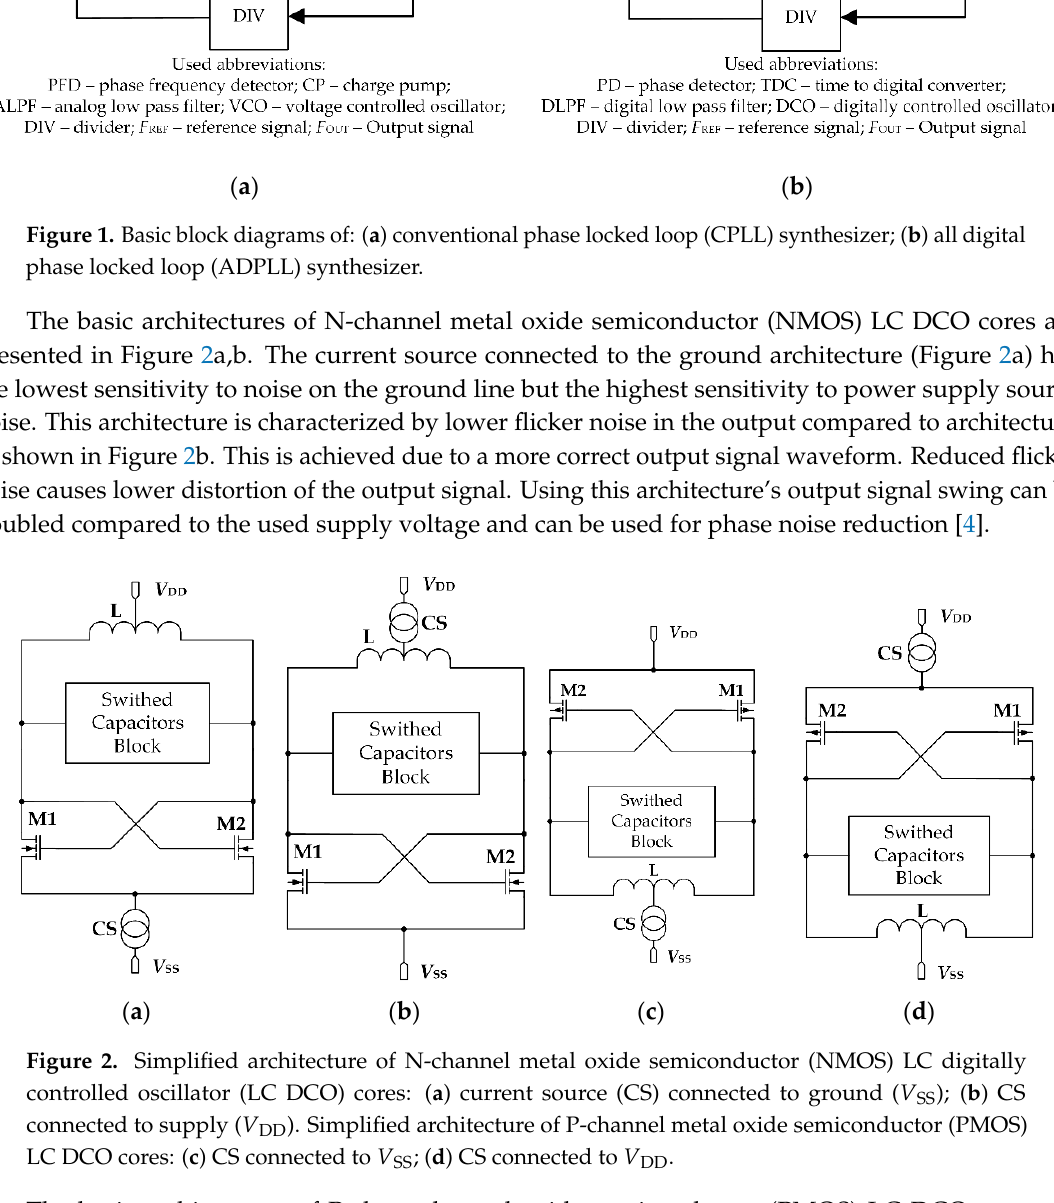
Figure 1. Basic block diagrams of: ( a ) conventional phase locked loop (CPLL) synthesizer; ( b ) all digital phase locked loop (ADPLL) synthesizer.